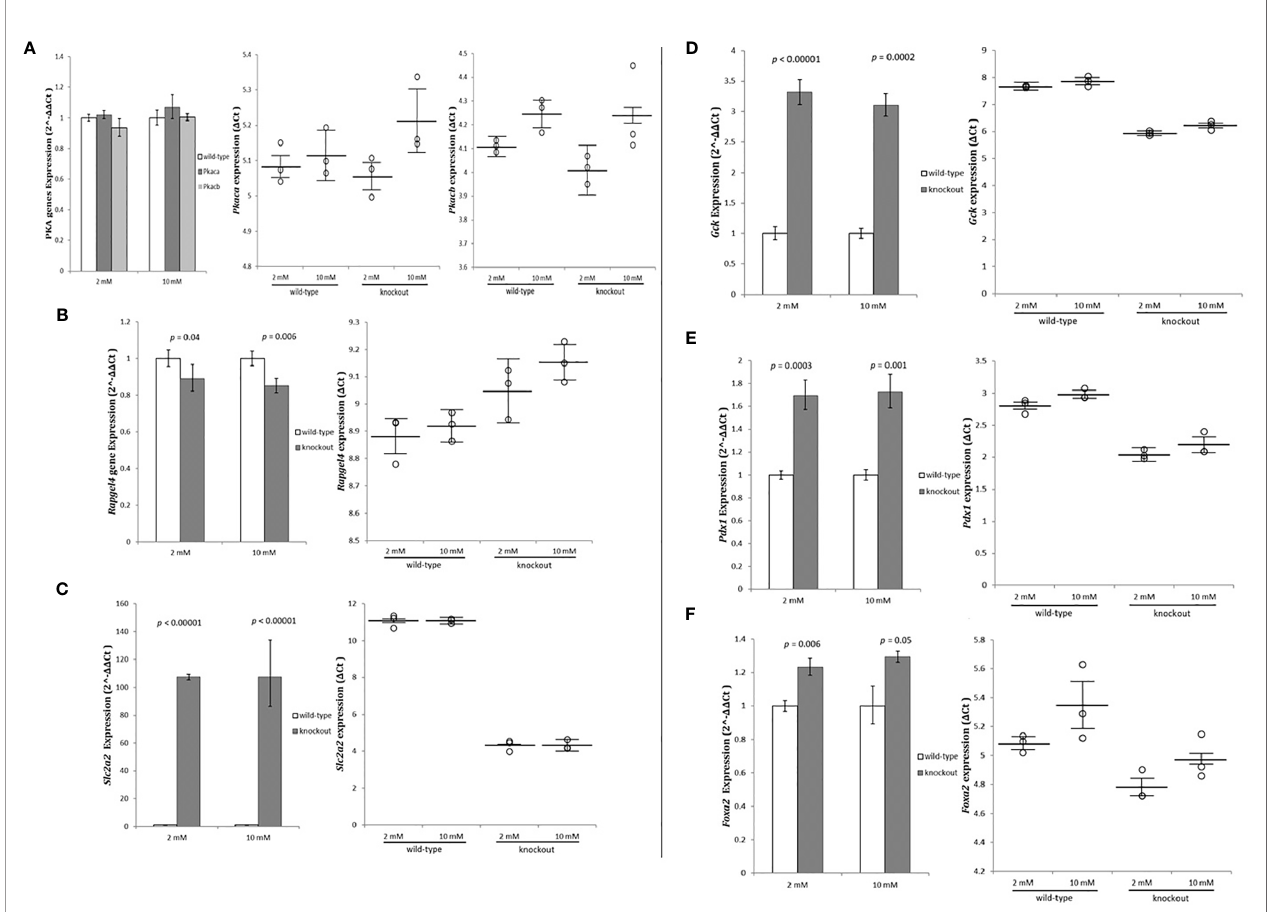
FIGURE 4 | Exome data analysis strategy. RIN-m (-/- Adcy7 ) mRNA level under 2mM glucose and 10mM glucose concentration established by quantitative RT-PCR. The CT values were normalized to b -actin to yield D CT and 2^- DD CT values presented in dots and bar chart, respectively. Each dot represents an individual sample, whereas the horizontal lines represent the mean and standard error of the mean. D CT values were then calculated and presented as 2^- DD CT values (fold change) in a bar chart. (A) PRKACs alpha ( Prkaca ) and beta ( Prkacb ) expressions, (B) Rapgef4 , (C) Slc2a2 , (D) Gck , (E) Pdx1 , (F) Foxa2 . Unpaired t-test with delta CT and SE ± values were used for statistic